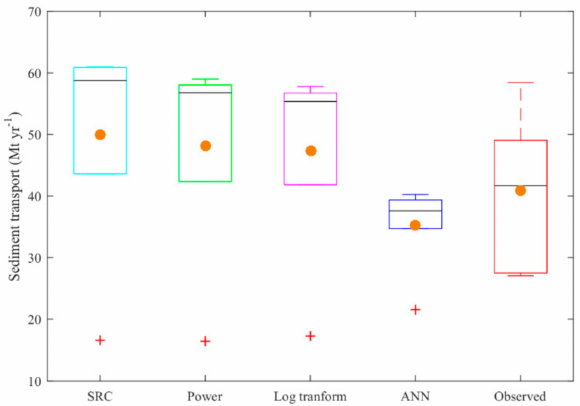
Figure 13. Comparison of di ff erent models’ predicted and observed yearly total suspended sediment transport. Central lines indicate the median, and bottom and top edges of the box indicate the 25th and 75th percentiles, respectively. The whiskers extend to the most extreme data points not considered outliers, the ‘ + ’ symbol represents outliers (1.5-fold interquartile range), and the circle shows the mean